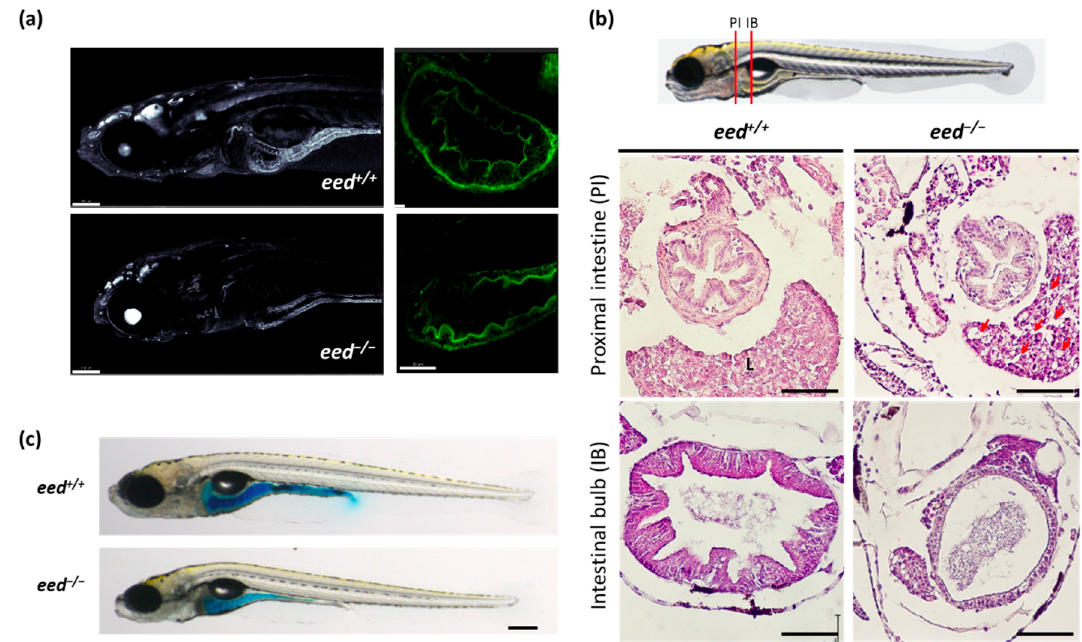
Figure 5. Structure of the intestine at 9–11 dpf: ( a ). confocal imaging of the anterior part (left, scale bar is 150 μ m) and of the intestine bulb (right, scale bar is 50 μ m) of transgenic Tg (actb2:GFP ‐ Hsa.UTRN) e116 zebrafish larvae, wild ‐ type (up) or lacking eed function (down) at 9 dpf; ( b ) histological sections stained with hematoxylin and eosin at the levels of the proximal intestine (PI) and the intestinal bulb (IB) as indicated from eed +/+ (left) and eed − / − (right) siblings at 11 dpf. Red arrows show macrovesicles. L, liver. Scale bar is 50 μ m; ( c ) Smurf assay performed on eed +/+ and eed − / − siblings at 11 dpf. Scale bar is 200 μ m.